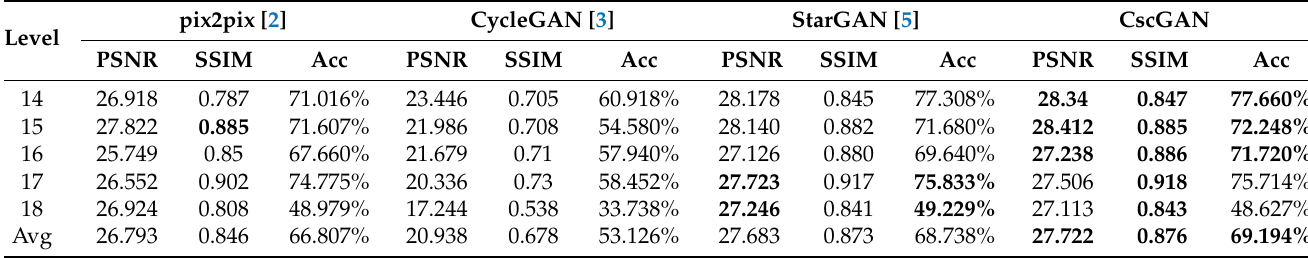
Table 7. The generalization results via different methods, we use the study areas in Shanghai for training while other areas in Wuhan for testing. Note that the best results are highlighted in